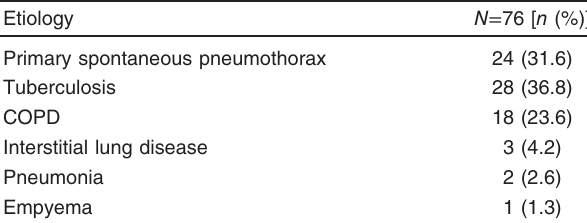
Table 3 Etiology of spontaneous